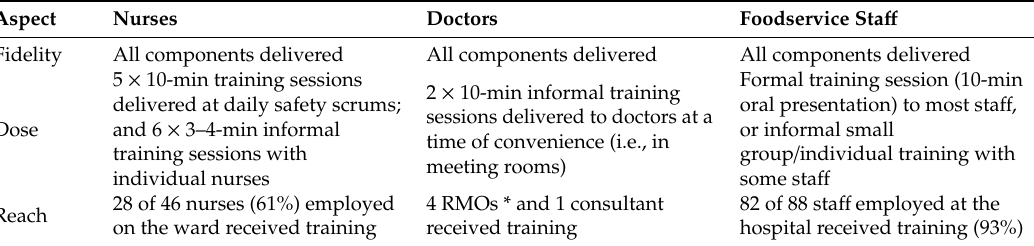
Sta ff -level implementation: delivery of the sta ff -level intervention (discipline specific sta ff training) in terms of fidelity, dose and reach is described in Table 3 below. Table 3. Delivery of sta ff